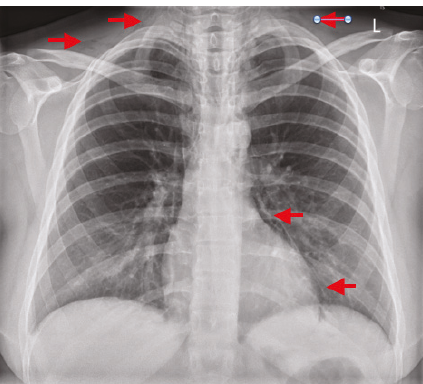
Figure 1: CXR confirmed the presence of free air in the pleural spaces and pneumomediastinum.